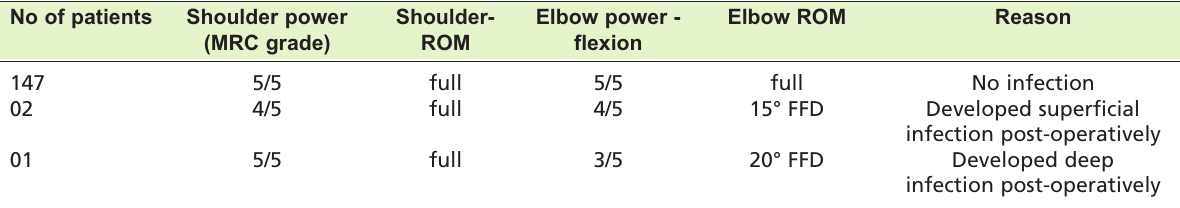
Shoulder and Elbow range of motion and muscle power after surgery Table III: